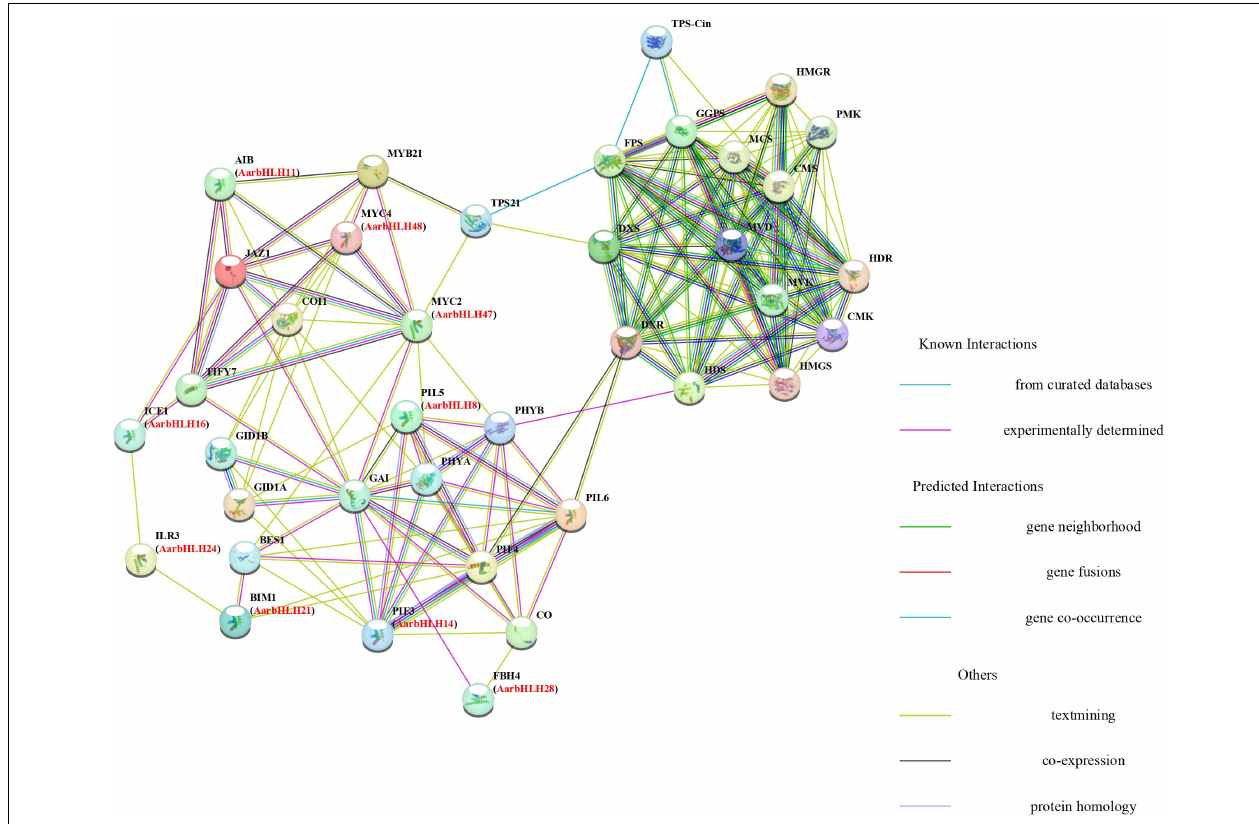
FIGURE 9 | Protein–protein interaction networks analysis between candidate TPS-AarbHLHs and terpenoid biosynthesis enzyme proteins using Arabidopsis thaliana orthologs. Predictions were completed using STRING 11, and candidate TPS-AarbHLHs were listed in brackets with their Arabidopsis thaliana